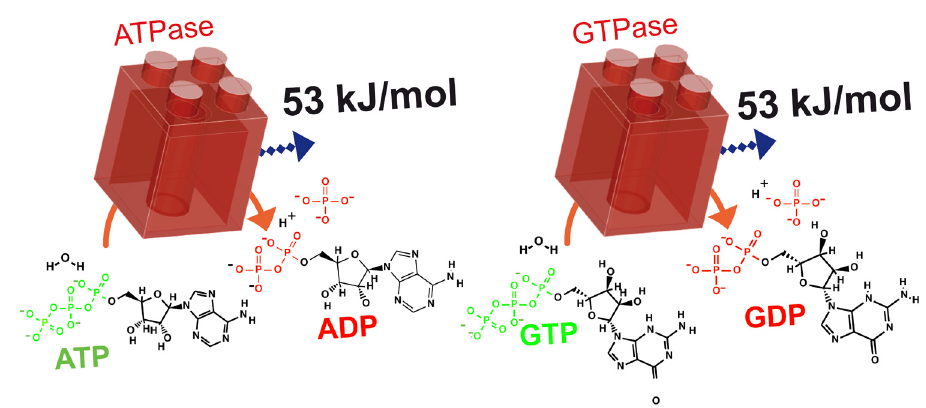
Figure 1. ATP and GTP hydrolysis release the same quantity of energy. ATPases and GTPases hydrolyse their NTP substrates to NDP and inorganic phosphate; both hydrolysis reactions liberate 53 kJ/mol Gibbs free energy. ATP, adenosine 5’-triphosphate; GTP, guanosine 5’-triphosphate; NTP, nucleoside triphosphate; NDP, nucleoside diphosphate; P